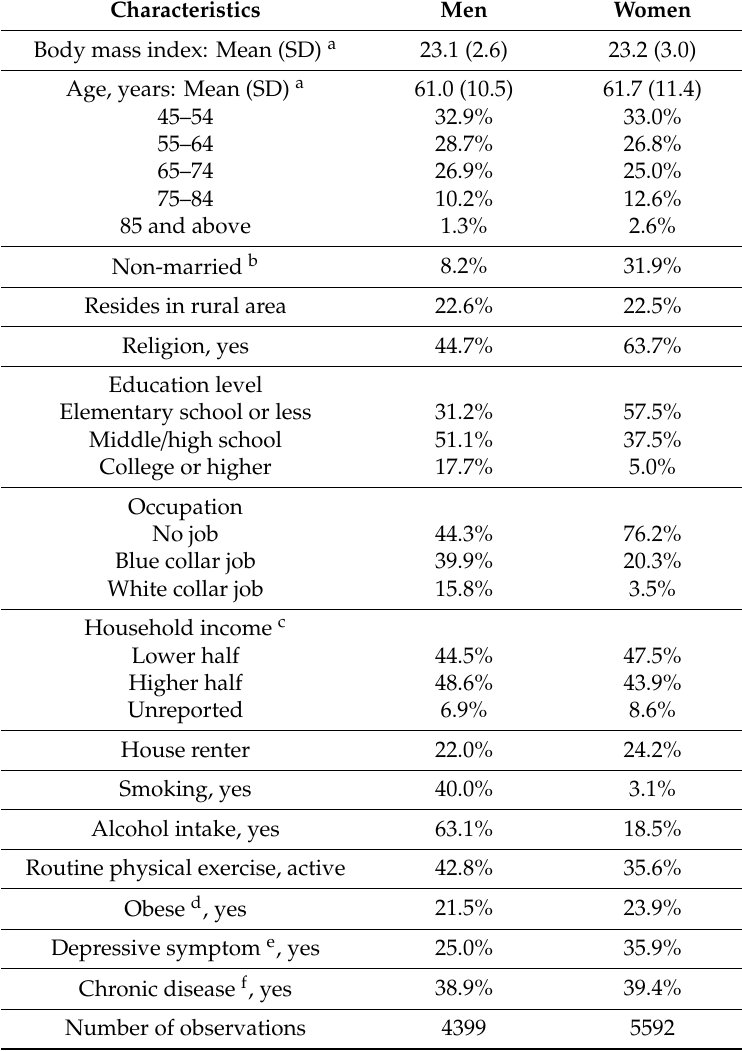
Table 1. Sample characteristics by gender at baseline (Wave